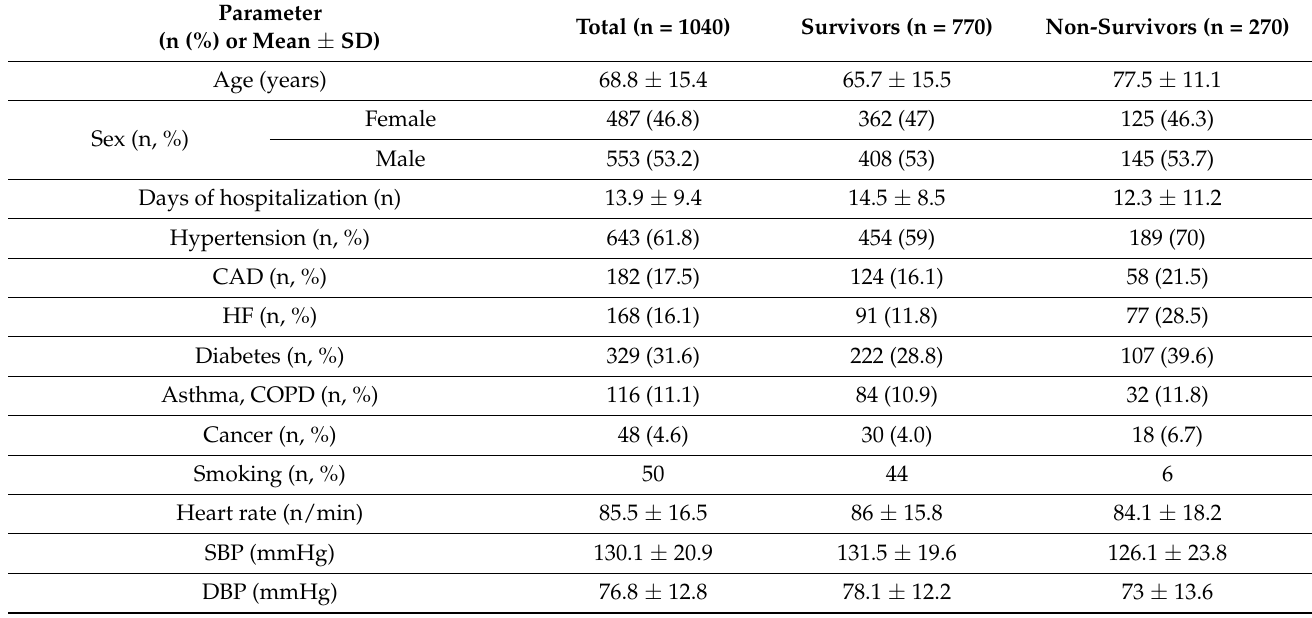
Table 1. General characteristics of both